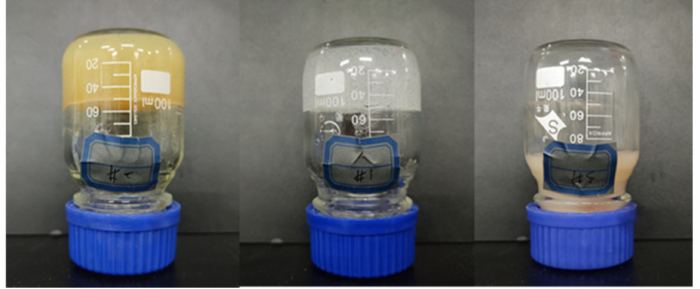
Figure 5. The pictures of inverted bottles containing JM186 ( left ), #1 ( middle ), and #2 ( right ). From Figure 4, G” and G’ of JM186 reach 32.33 Pa and 3.25 Pa at 0.1 Hz, respectively. G” and G’ for sample #1 are only 31.45 Pa and 3.06 Pa at 0.1 Hz, respectively. For sample #2, G” is 1.544 Pa and G’ is 0.648 Pa at 0.1 Hz. The G’ and G” of JM186 were similar to those of #1 and much larger than those of #2. This indicates that the organic zirconium